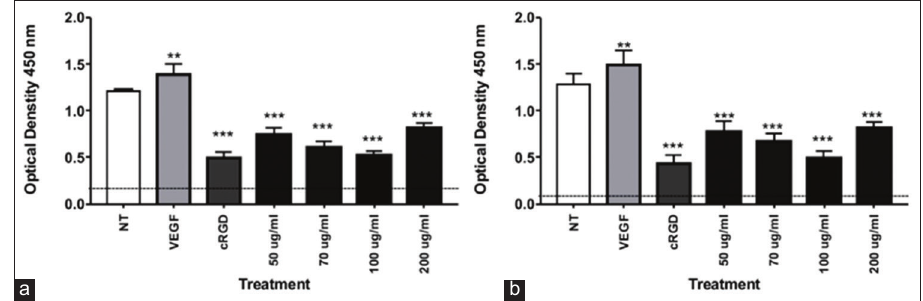
Figure-3: (a and b) Ocimum sanctum extract significantly decreases A549 expression of matrix metalloproteinase (MMP)-2 and MMP-9. A549 lysates were analyzed using human MMP-2 and MMP-9 enzyme-linked immunosorbent assay kits. Statistical analysis was performed by one-way analysis of variance followed by Tukey’s post hoc test as appropriate